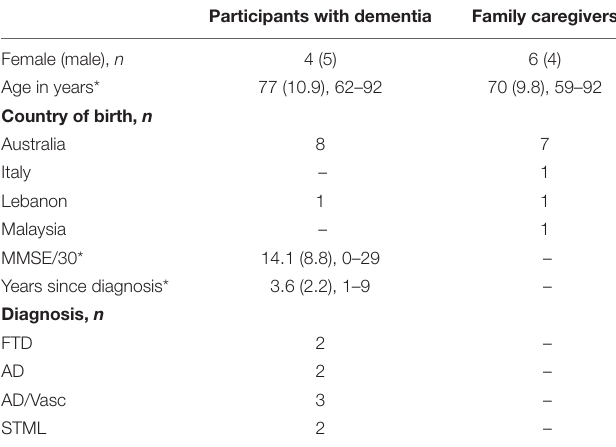
TABLE 1 | Participant